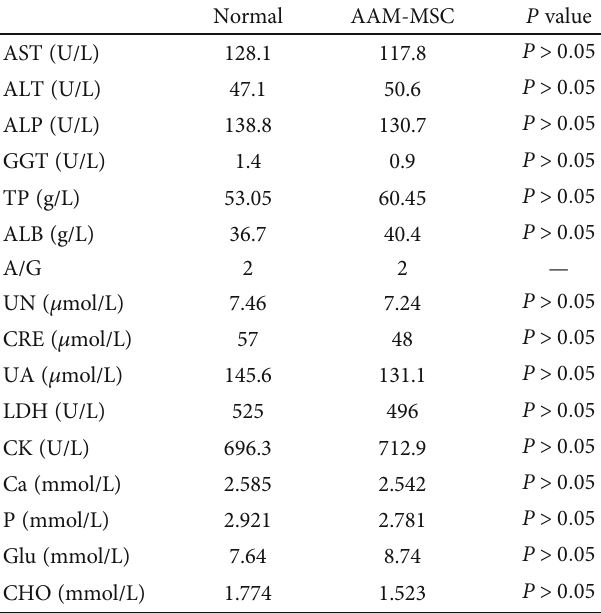
Table 4: Blood chemistry results three estrus cycles after UCMSC- AAM